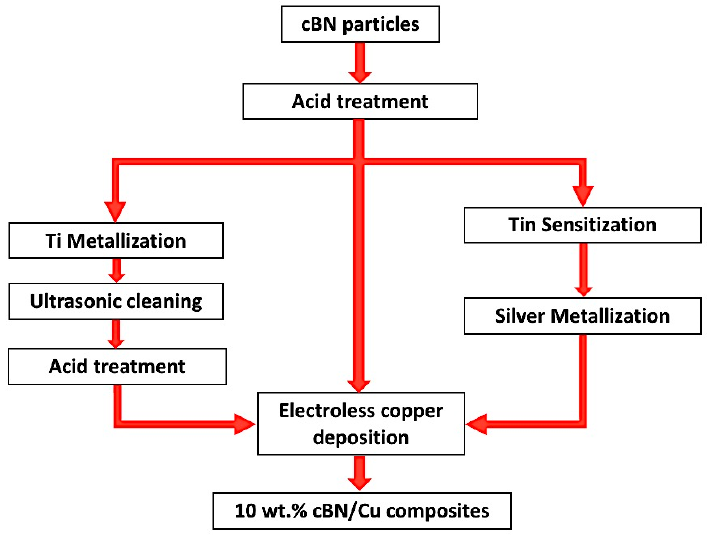
Figure 2. Schematic flowchart of the polycrystalline cBN/Cu composite particles fabrication process.